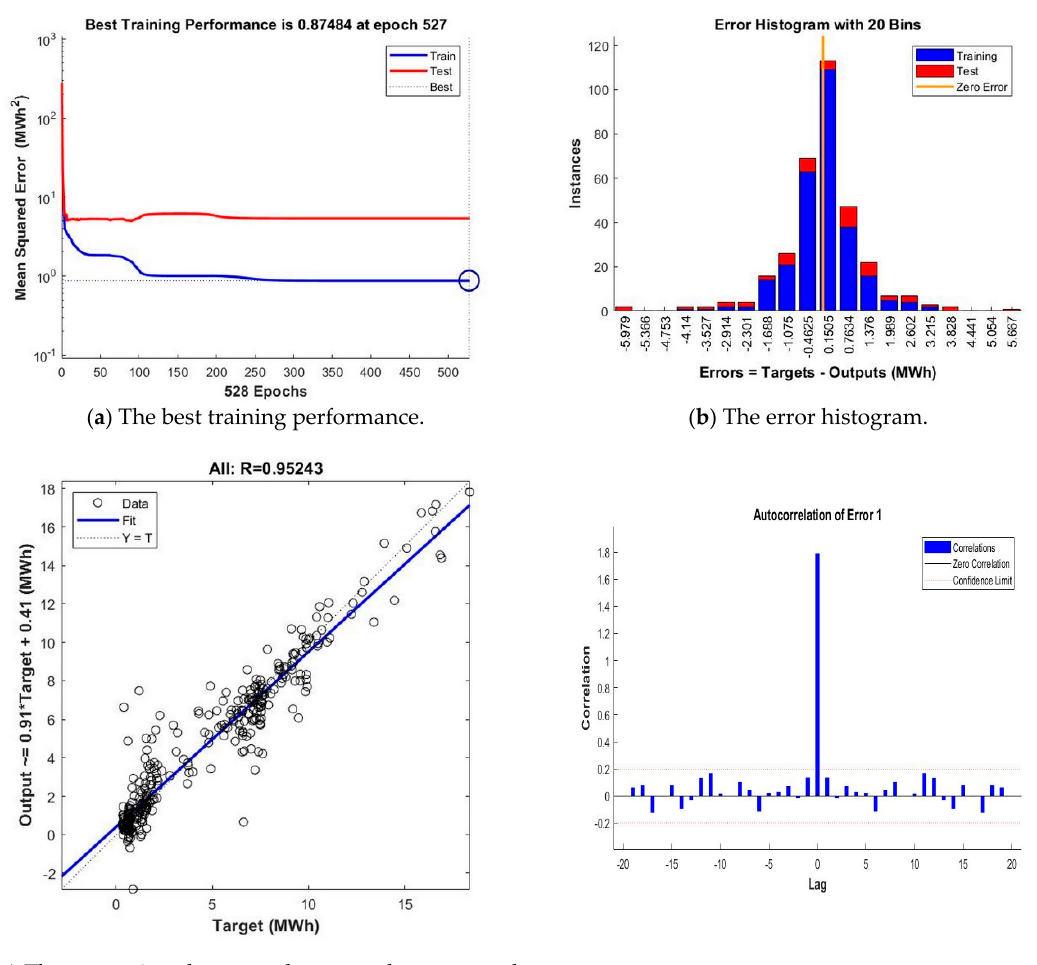
Figure 3. The performance plots of the BEST_NARX network.